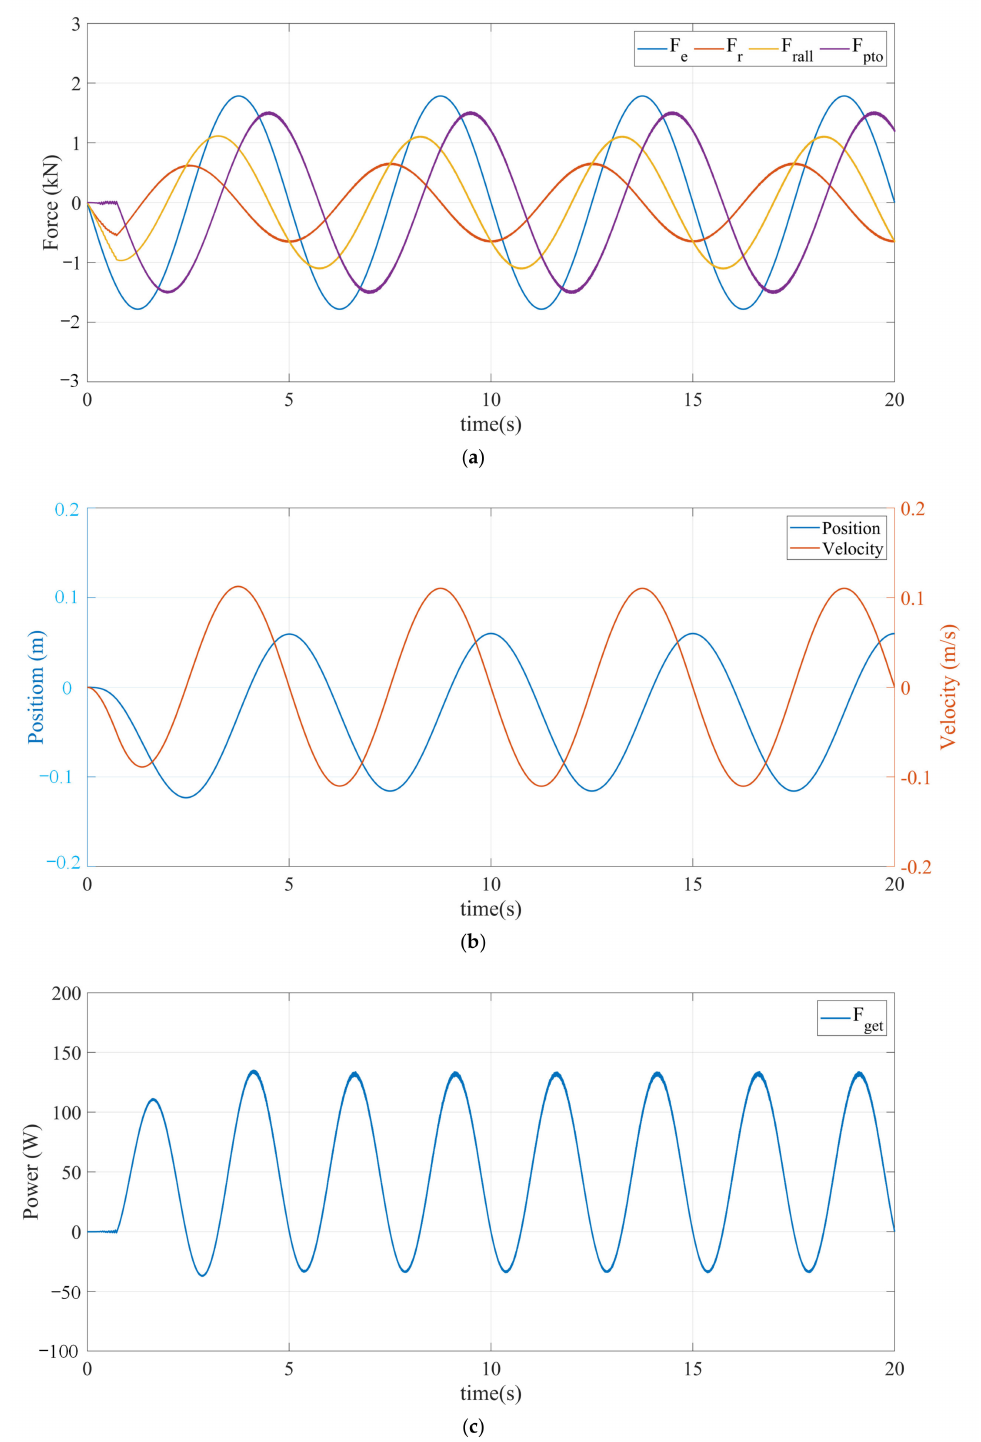
Figure 11. Mechanical dynamic response of DDWEC: ( a ) Force in buoy and generator; ( b ) Position and velocity of buoy; ( c ) Power capture in